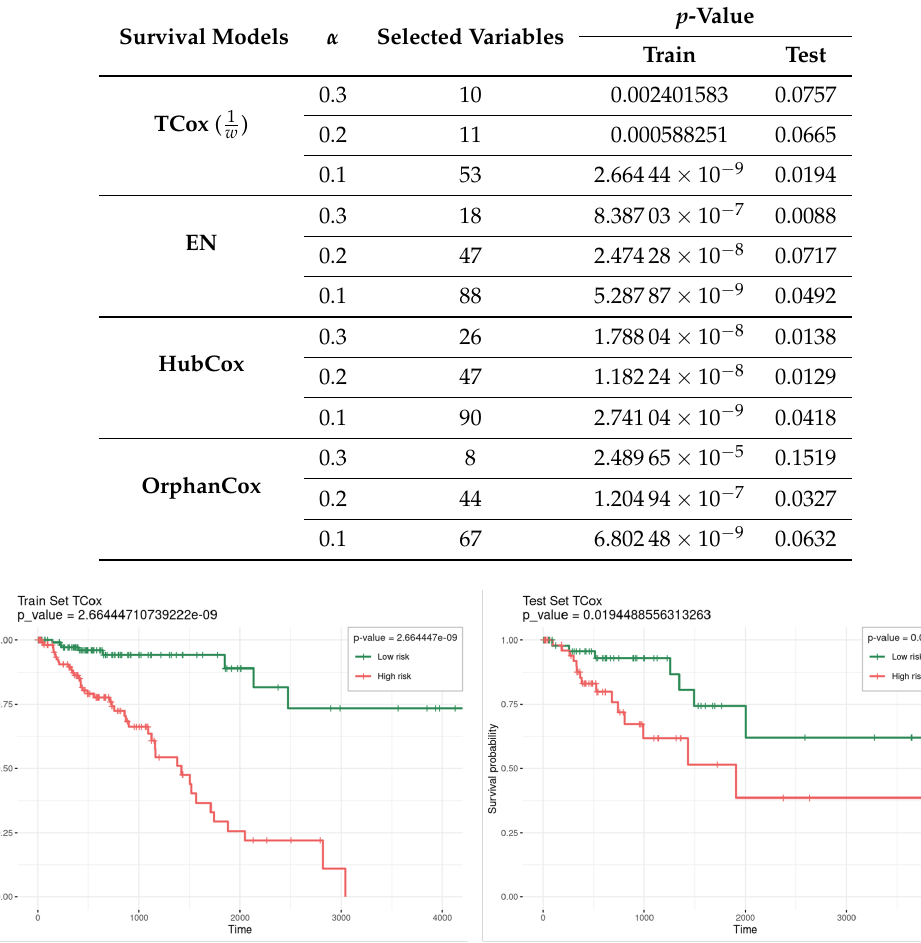
Table 2. Summary of TCox , EN, HubCox, and OrphanCox model results showing the number of selected variables and the p -values obtained for the training and test sets.